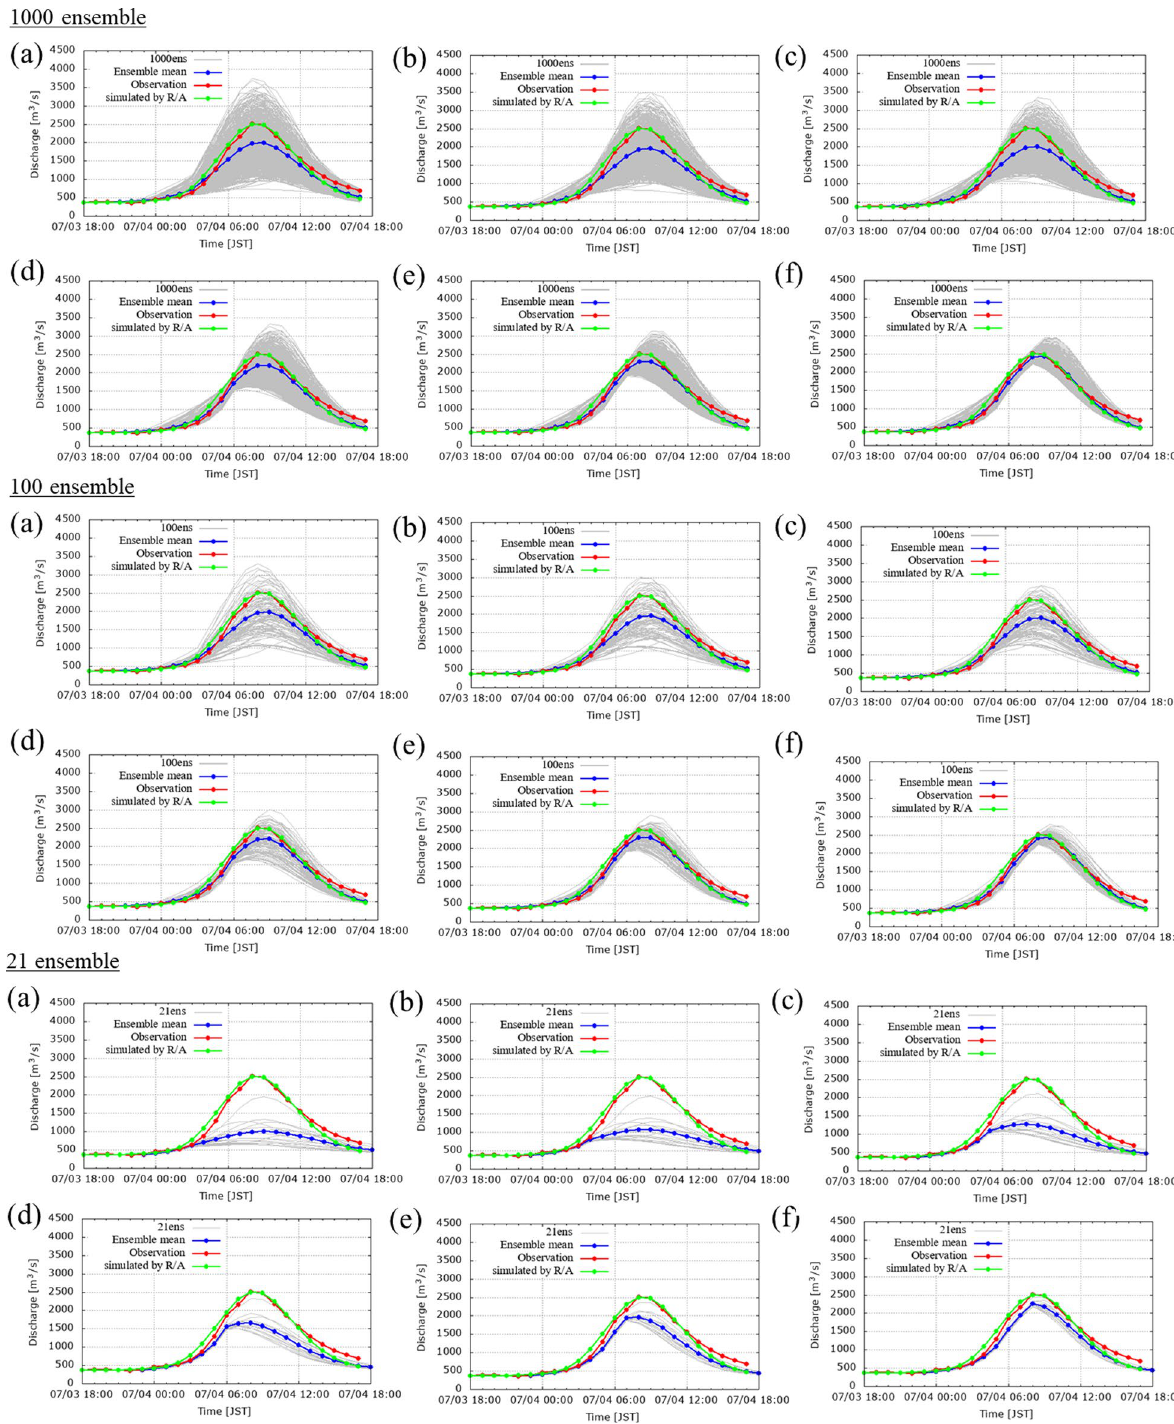
Fig. 18 Application of the Kalman filter on the discharge simulations of 21, 100 and 1000 ensembles for Kawabegawa dam ( a – g ): The Kalman filter was applied until: a 11, b 12, c 13, d 14, e 15 and f 16